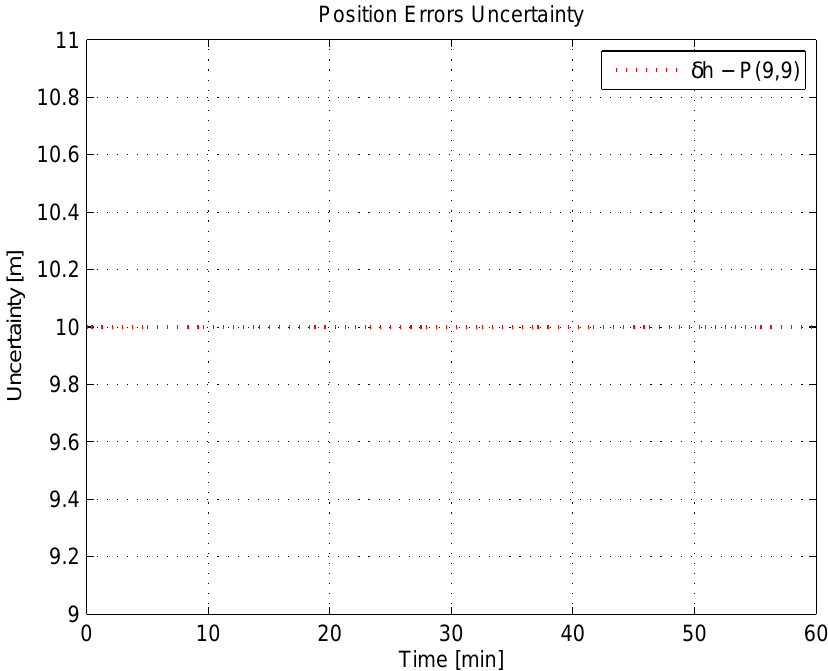
Figure 4. Position errors uncertainty in the simulated test,